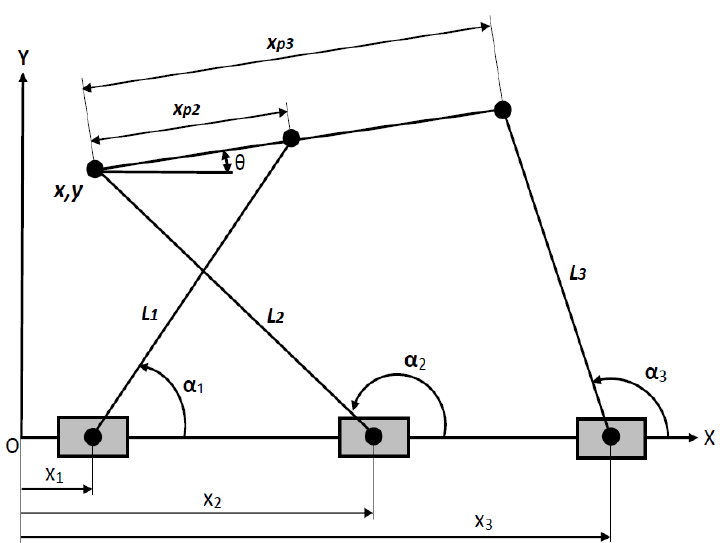
Figure 1. Planar 3PRR parallel kinematics mechanism (with the Z-axis perpendicular to the paper).